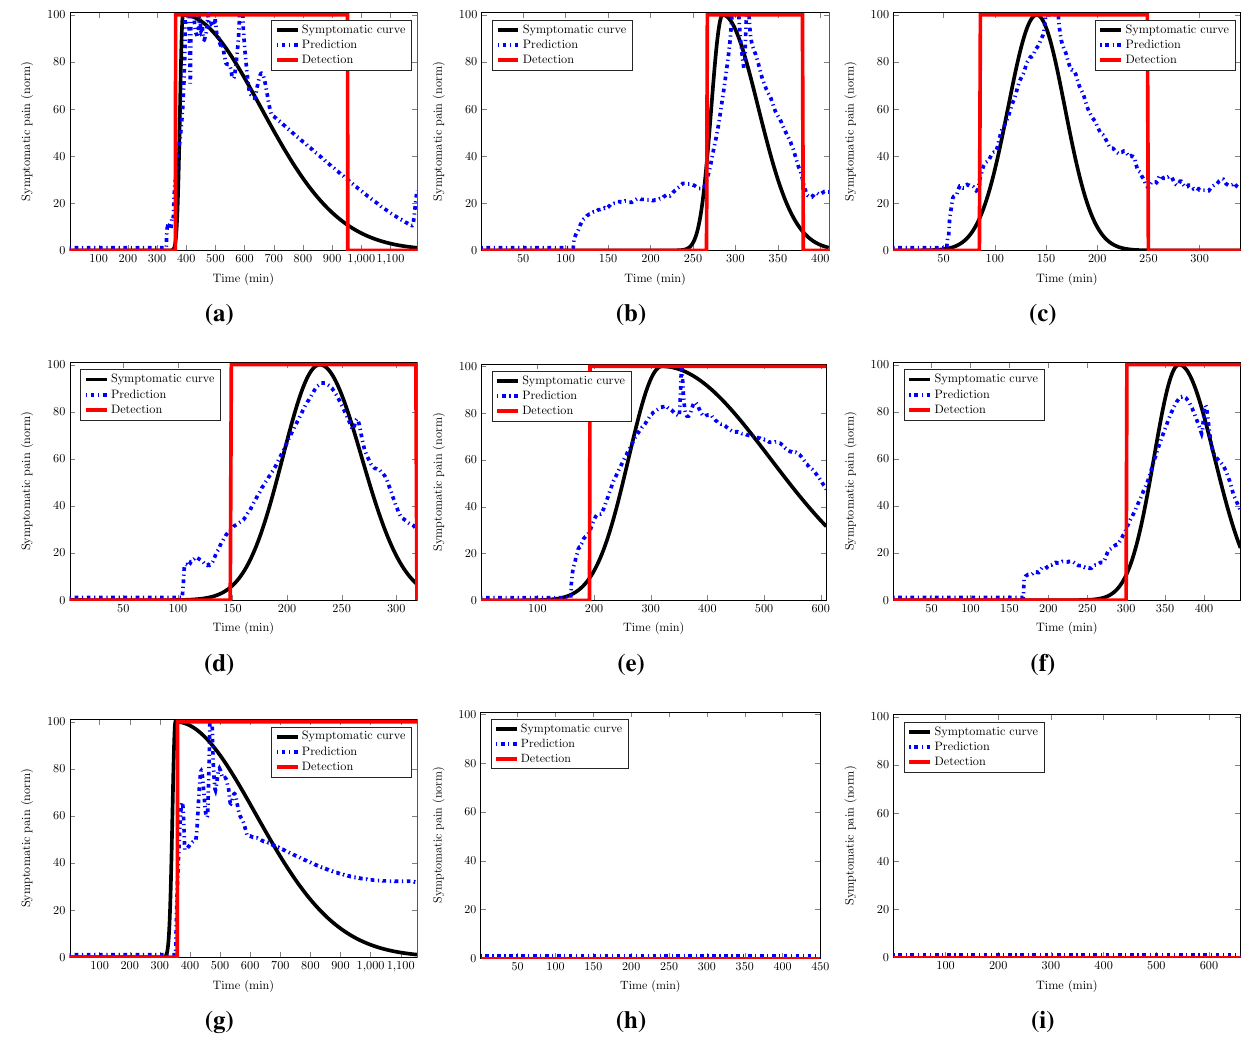
Figure 9. Test results for symptomatic and baselines periods for the trained patients. ( a ) Patient A, fit = 75.7%; ( b ) Patient A, fit = 55.0%; ( c ) Patient A → B, fit = 73.9% for TEMP-EDA-SpO2; ( d ) Patient B, fit = 88.9%; ( e ) Patient B, fit = 79.3%; ( f ) Patient B, fit = 81.1% for EDA-HR-SpO2; ( g ) Patient B → A, fit = 31.6%; ( h ) Basal Patient A; ( i ) Basal Patient A →